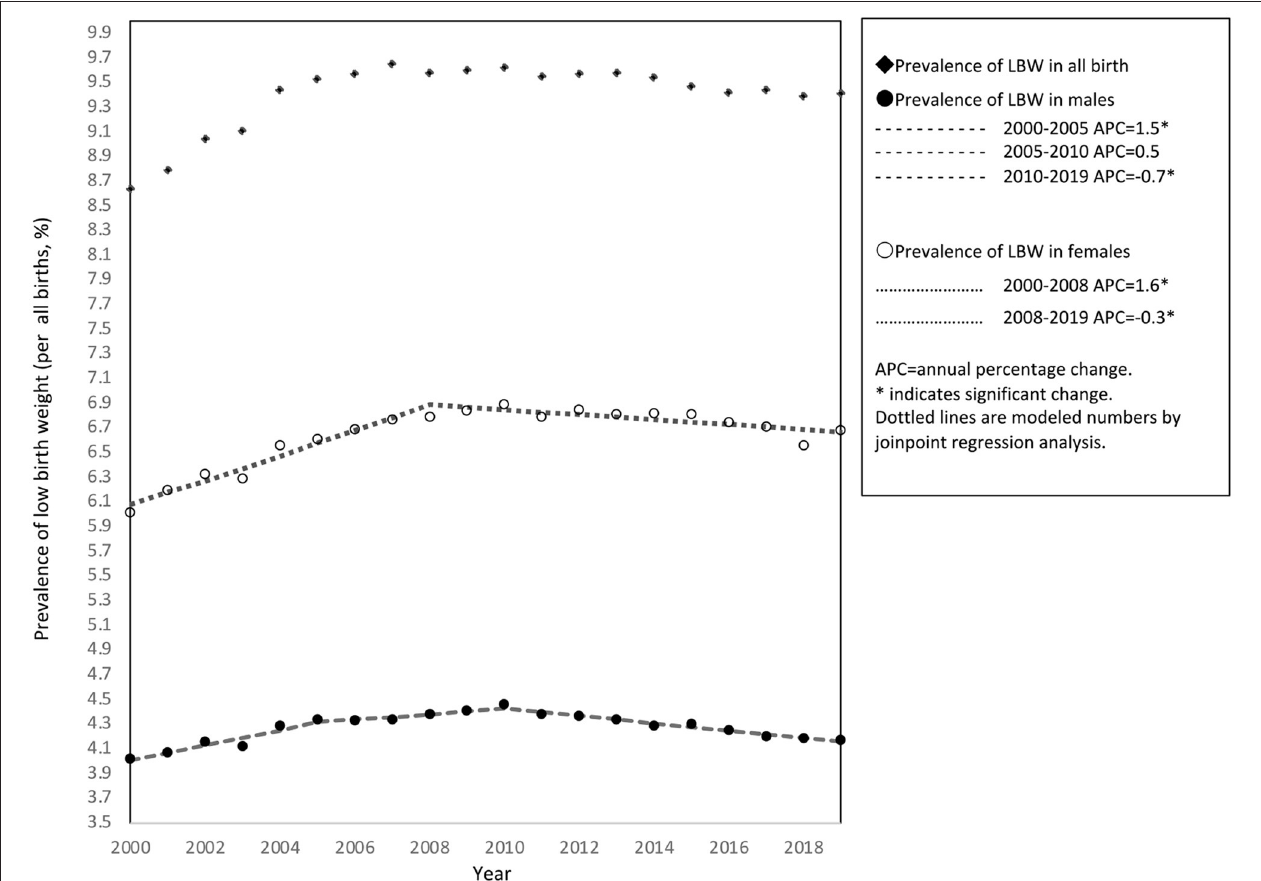
FIGURE 1 | Trends in the prevalence of low birth weight in singleton, full-term births by sex in Japan, 2000–2019.